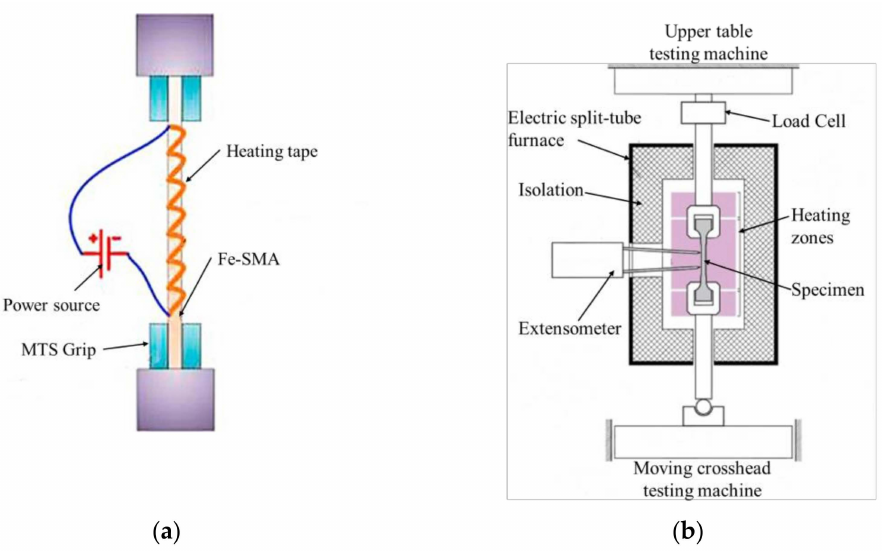
Figure 8. Schematic drawing of Fe-SMAs activation: ( a ) activated by heating tape [100]; ( b ) activated by split-tube furnace